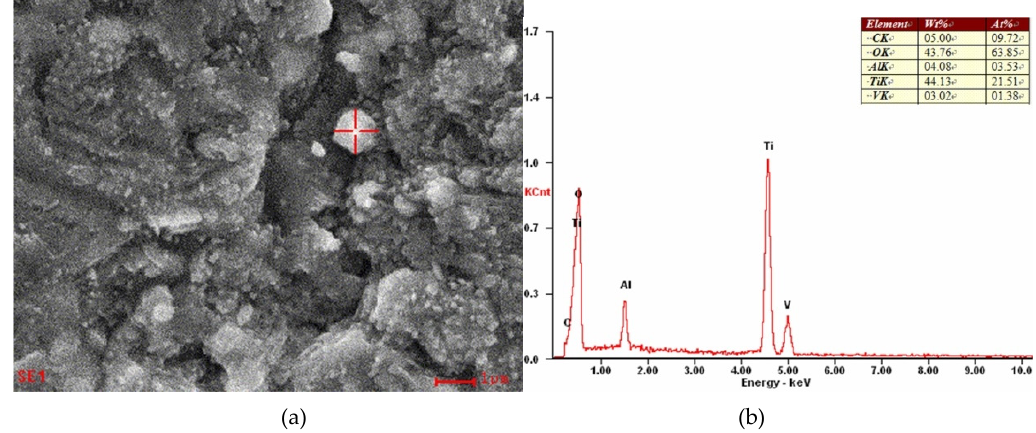
Figure 5. Micromorphology and EDS analysis of experimental surface of titanium alloy in air. (a) Micromorphology; (b) EDS analysis.